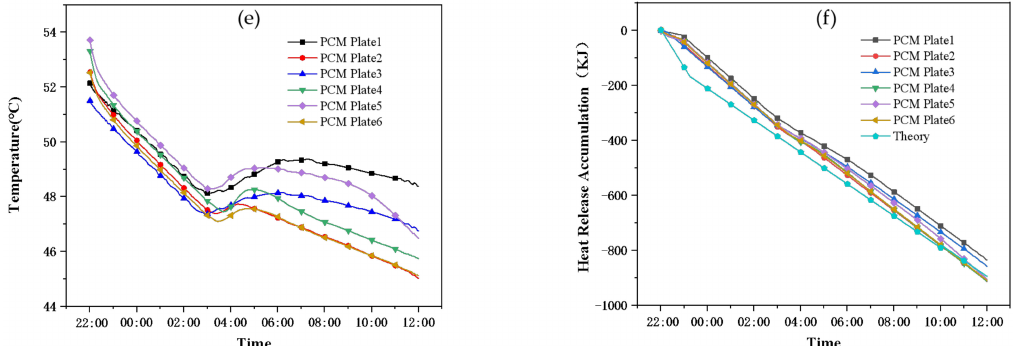
Figure 8. In working condition 3: ( a ) Water temperature curve of the PCM storage tank; ( b ) Water temperature curve of the common tank; ( c ) Heat release accumulation curve of the PCM storage tank; ( d ) Heat release accumulation curve of the common tank; ( e ) Temperature curve of the PCM plate; ( f ) Heat release accumulation curve of the PCM plate.